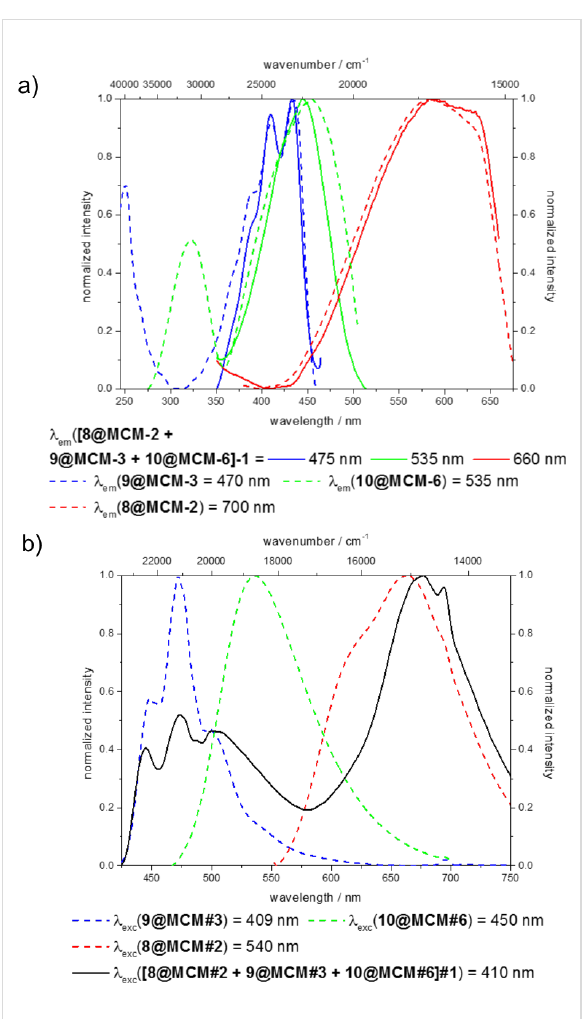
Figure 7: a) Excitation and b) emission spectra of the single dye-func- tionalized hybrid materials 8@MCM-2 , 9@MCM-3 , and 10@MCM-6 as